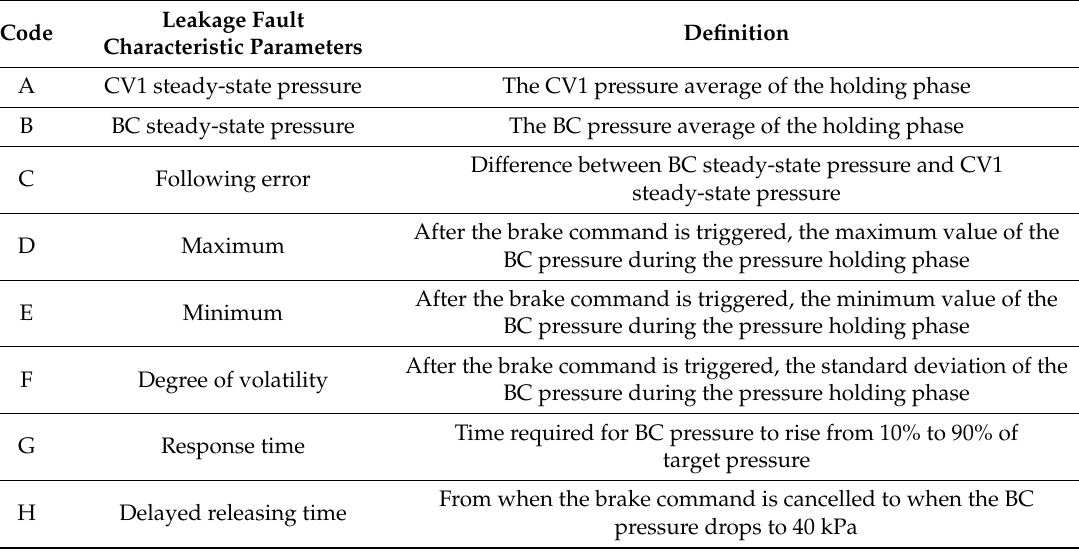
Table 2. Leakage fault characteristic parameters.